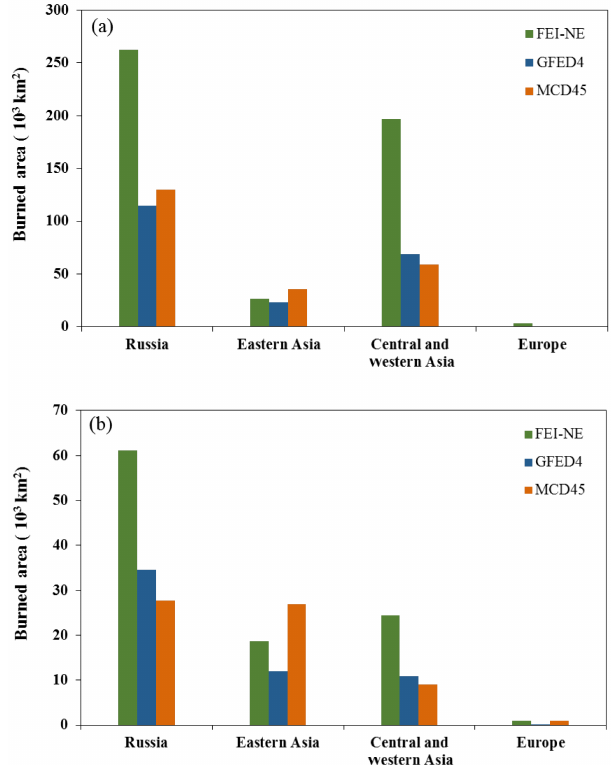
Figure 3. Comparisons of burned areas in (a) 2003 and (b) 2013 in different geographic regions in northern Eurasia mapped by FEI- NE, GFED4, and